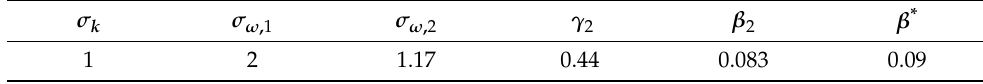
Table 1. Constants of the k − ω SST